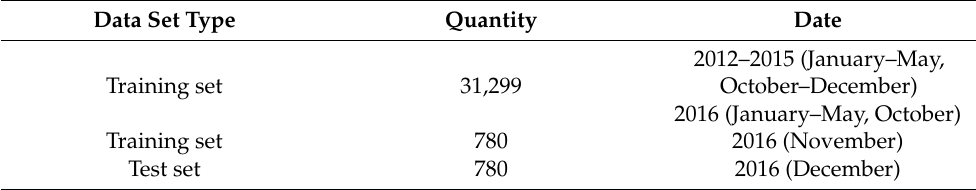
Table 3. Drier-Model’s data set